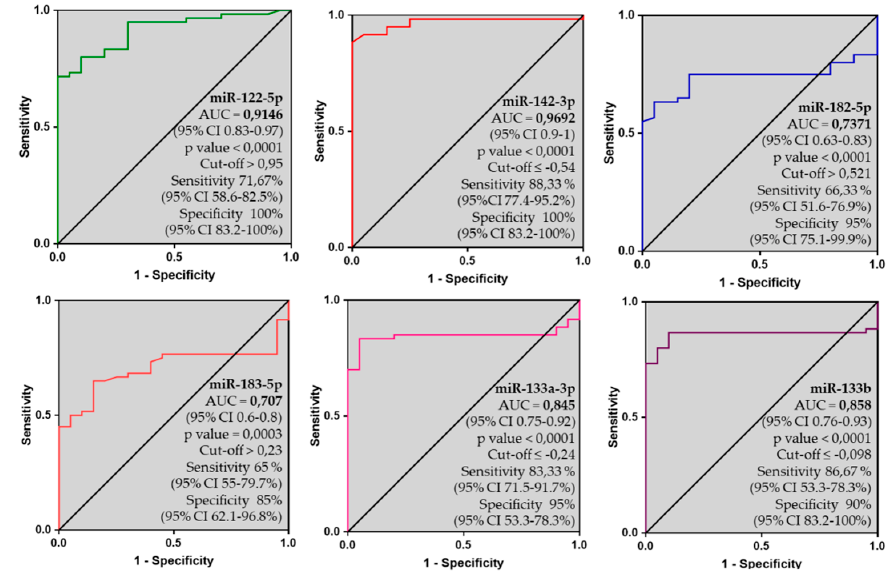
Figure 3. ROC plots, AUC values, 95% confidence interval, p values, cut-off, sensitivity and specificity of miR-122-5p, miR-142-3p, miR-182-5p, miR-183-5p, miR-133a-3p and miR-133b on 70-AC patients (gen+ and gen − ) vs. ctrl group.